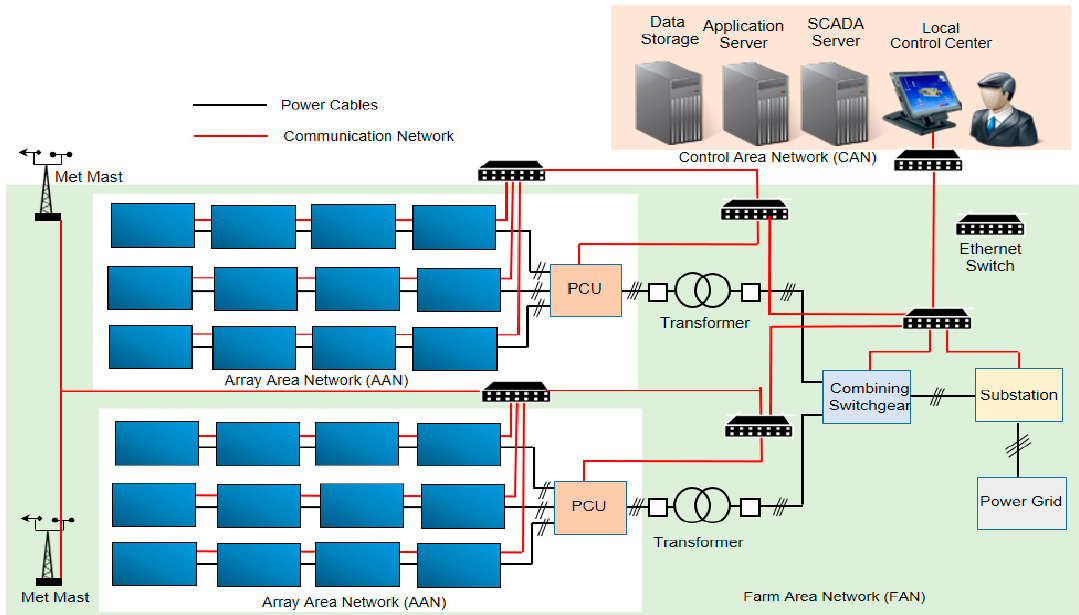
Figure 3. Layout of grid integration of a large-scale PV power plant.